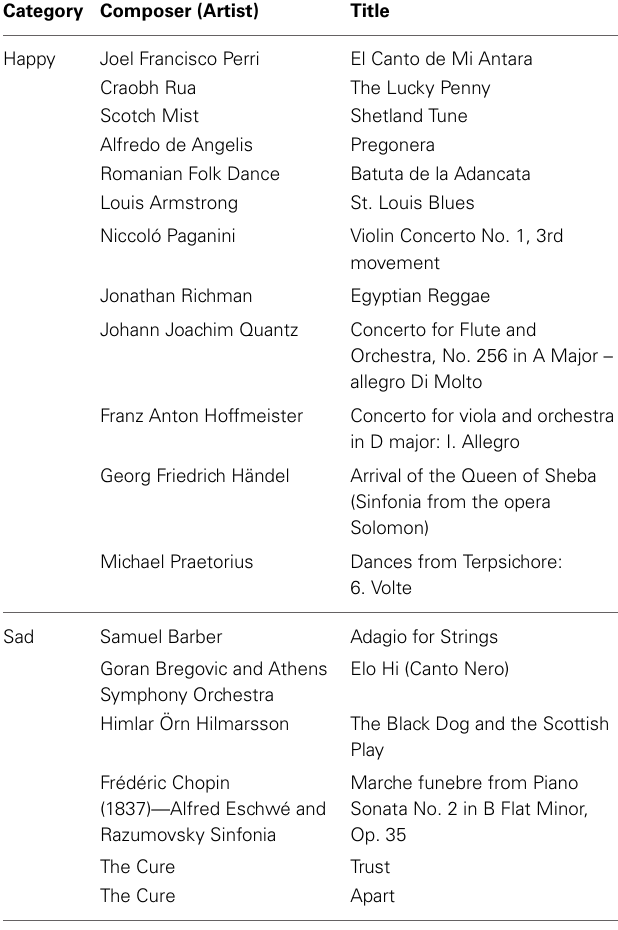
Table A2 | Musical stimuli.